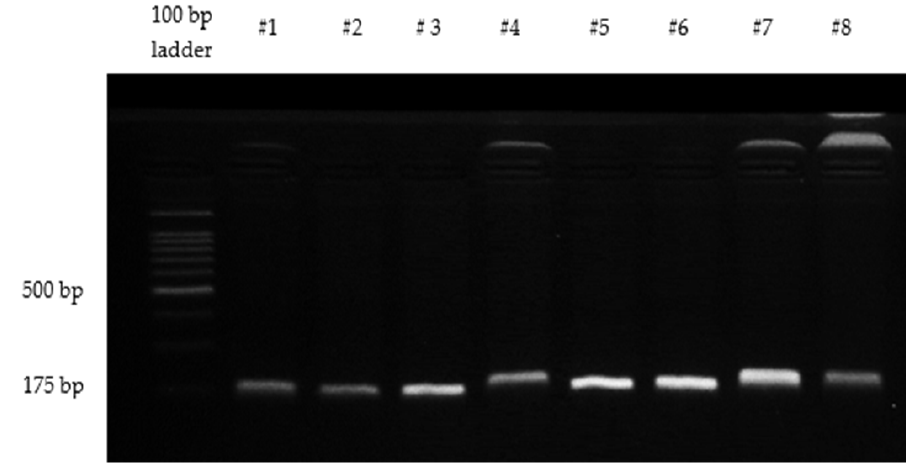
Figure 1. Gel electrophoresis image of selected PCR products targeting codons 12 and 13 of KRAS . 2.4. Statistical Analysis Results were presented as frequency ( n ) and percentage (%) for categorical variables. Comparison between groups was made using the chi-squared test or Fisher’s exact